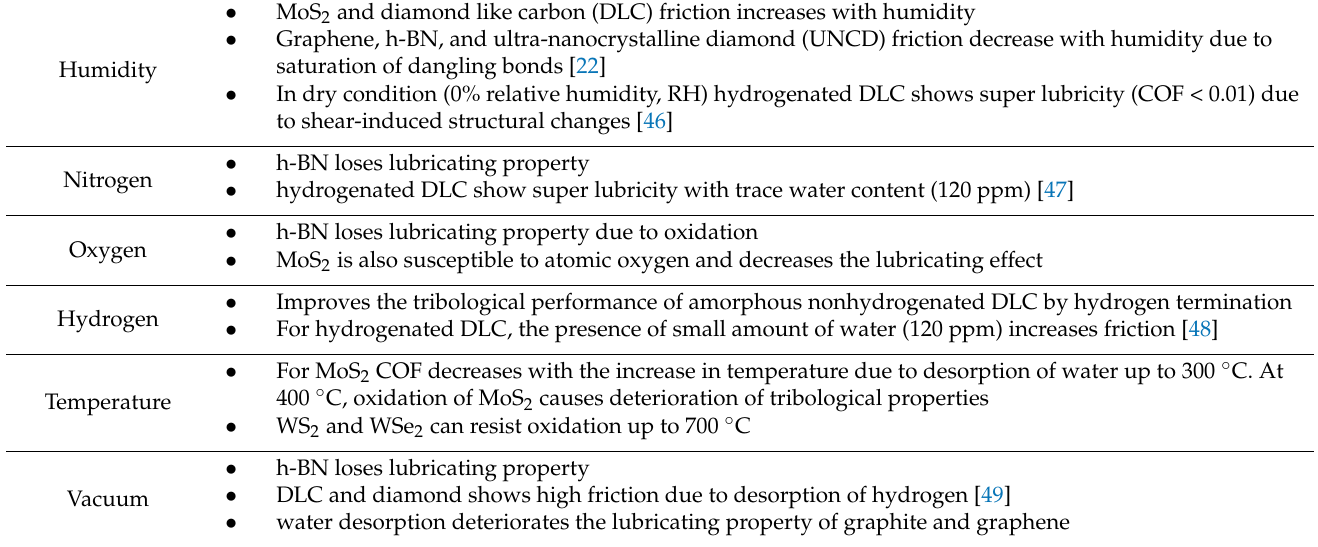
Table 2. Effect of environmental factors on the lubricating properties of some known solid lubricants.